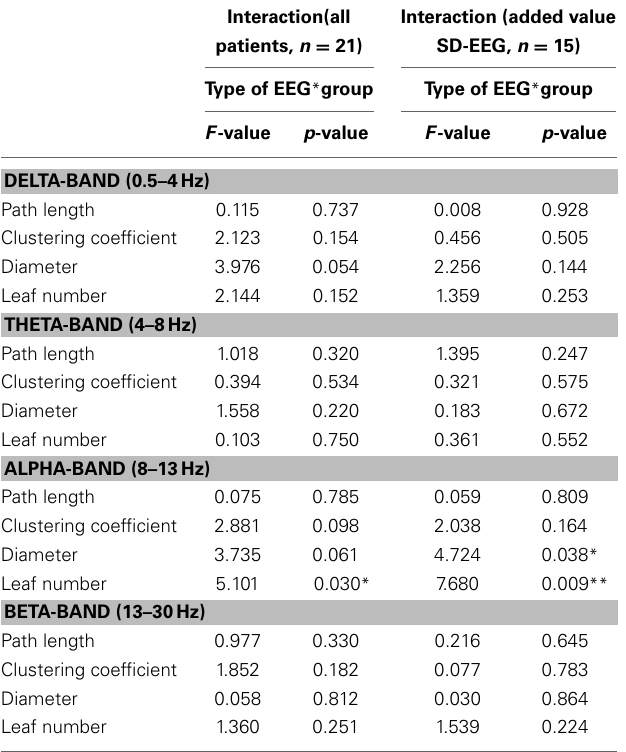
Table 4 | Interactions from repeated measures ANOVA for each network and MST measures.